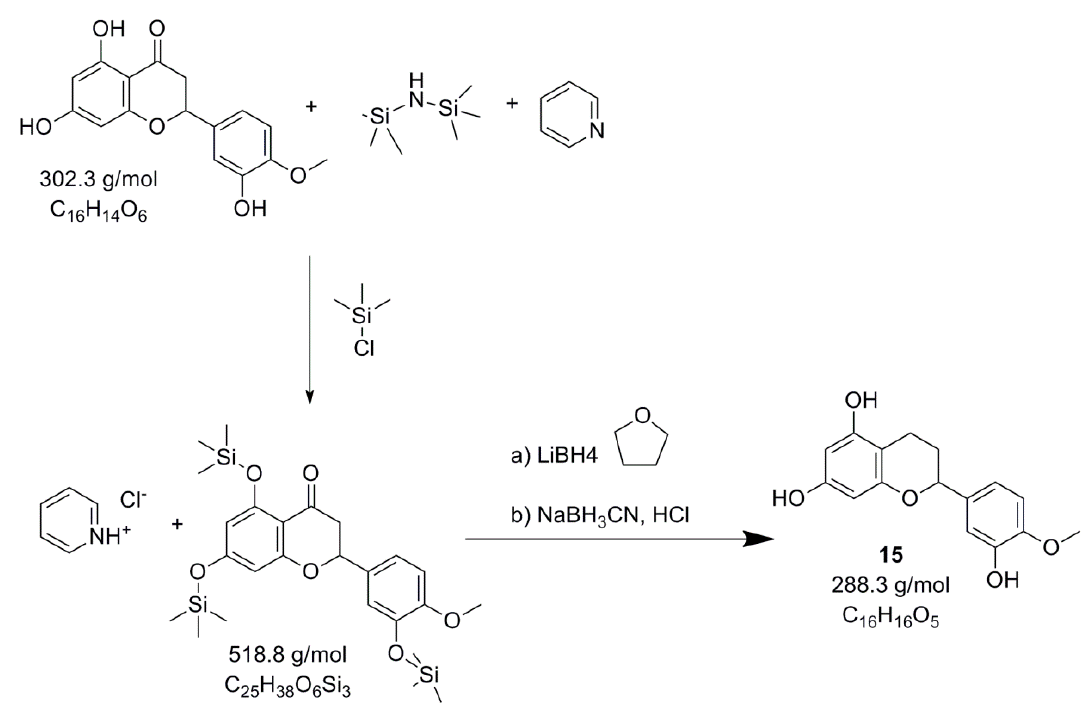
Figure A4. Preparation of compound 15 .